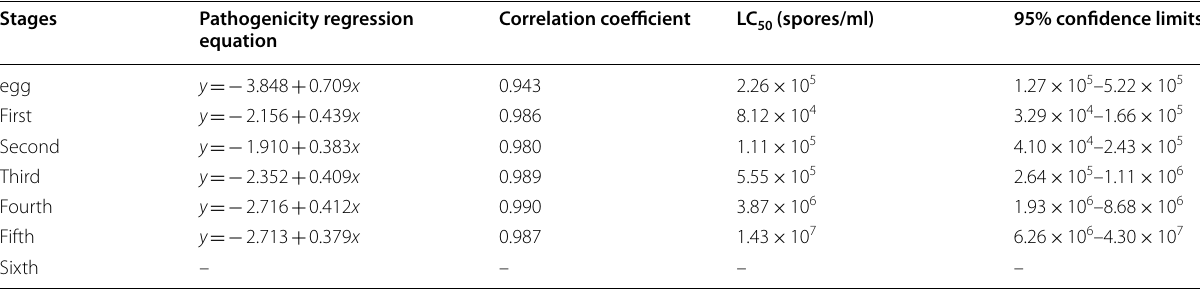
Table 3 Regression equation of pathogenicity of Metarhizium guizhouense Xct1 to Spodoptera frugiperda larvae